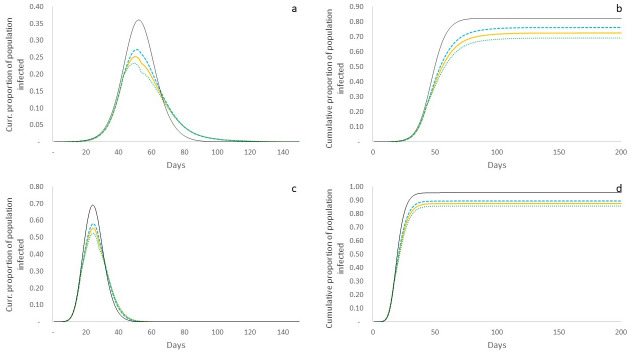
Simulated system outcomes in transmission probability reduction scenario.Yellow line represents overall population; dashed blue line represents poor population; dashed green line represents non-poor population; and thin black line represents non-intervention scenario for comparison. a: Current proportion of population infected over time on ER graph. Peak overall caseload is lower than non-intervention scenario, but poor population has a higher peak than non-poor. b: Cumulative proportion of population infected over time on ER graph. Cumulative infected is lower than under non-intervention, but the poor suffer a higher cumulative infection rate than the non-poor (76% v. 69%). c: Current proportion of population infected over time on BA graph. As in the case of the ER graph outcomes, peak caseload is lower than non-intervention scenario, but with a higher peak for the poor. d: Cumulative proportion of population infected over time on BA graph. Overall infected is lower than under non-intervention, with poor having an overall higher cumulative infection rate (89% v. 86%).